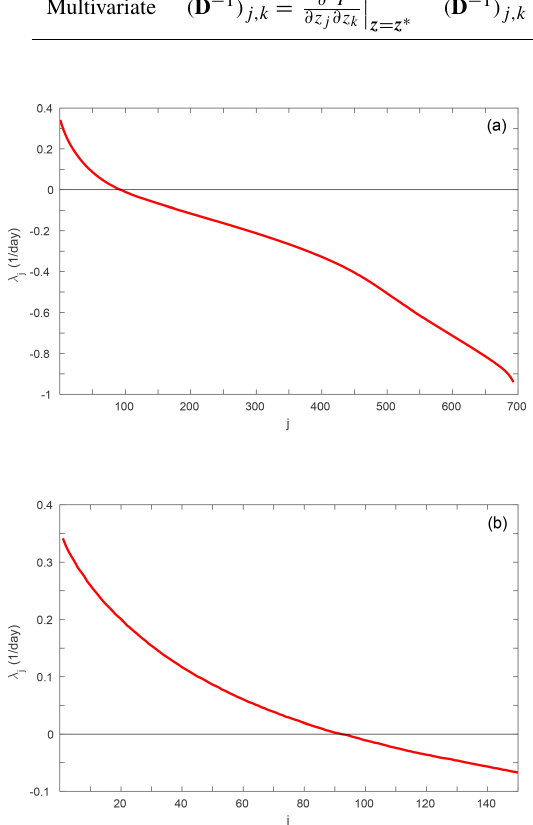
Figure 1. (a) Lyapunov spectrum of the QG model. (b) Close-up of (a)